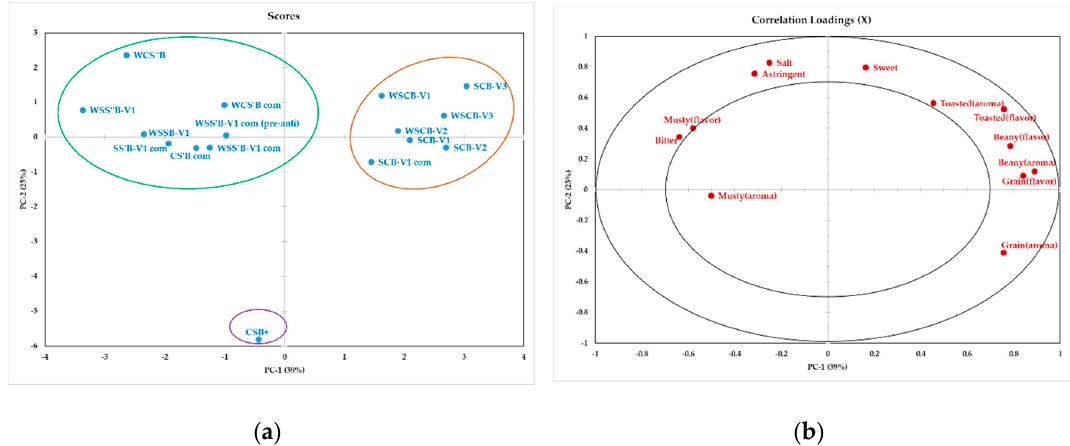
Figure 1. Principal component analysis of the porridges prepared from FBFs and sensory attributes ( a ) Score plot. ( b ) Correlation loading plot. For the FBFs, W = Whole, first S = Sorghum flour, first C = Degermed corn flour, second S = Low-fat soy flour, S’ = Medium-fat soy flour, S” = Full-fat soy flour, second C = Cowpea flour, V1 and V2 = White variety of sorghum, V3 = Red variety of sorghum, com = Commercial milling, (pre-anti) = Antioxidant had been added to the binary blend before extrusion process. CSB+ represents the control sample (current non-extruded FBF).